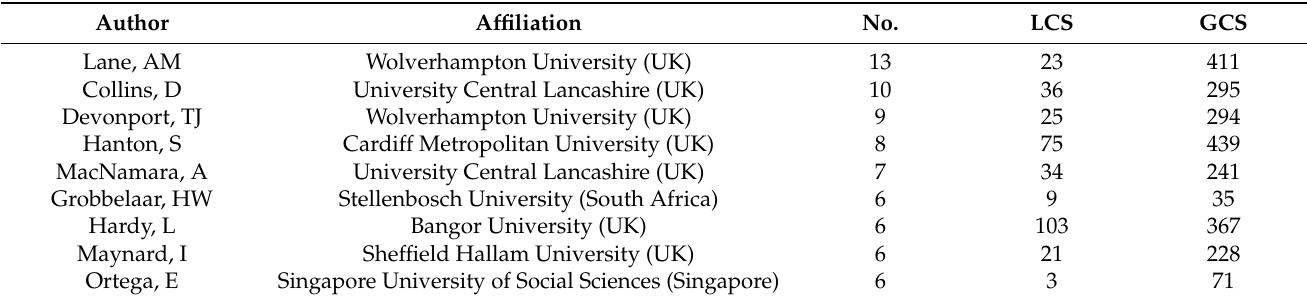
Table 1. Authors with the highest number of publications